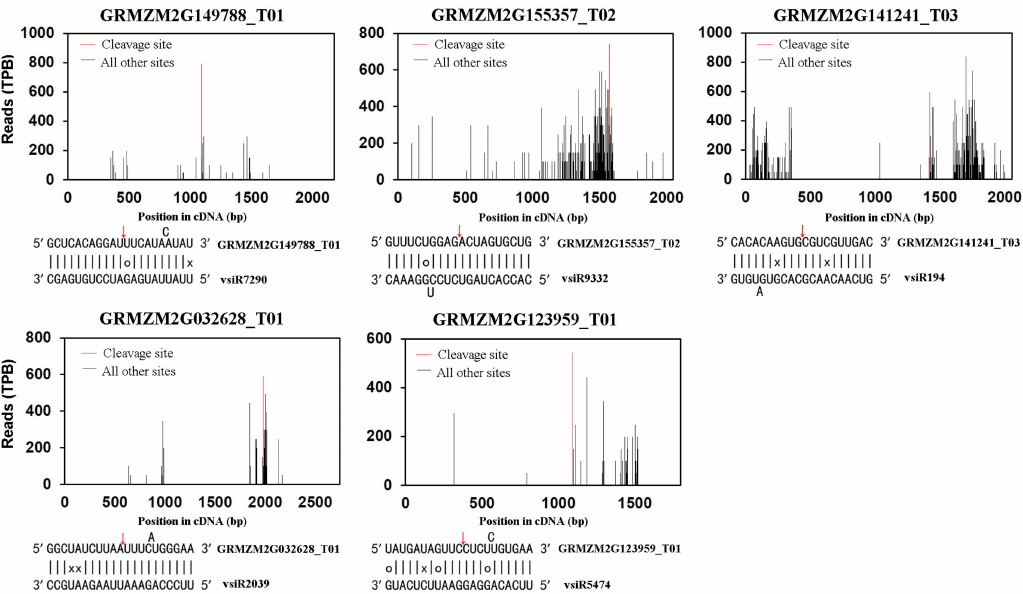
Figure 1. Identification of maize transcripts targeted by vsiRNAs through degradome sequencing. Target plots for the indicated genes showed sequencing signature abundance at the position of target transcripts identified through degradome sequencing. The red lines indicate the predicted vsiRNA cleavage sites. Signature abundance along the mRNA was normalized to the transcripts per billion (TPB) reads. The red arrows in the mRNAs represent the cleavage sites identified through degradome sequencing. Wobble G-U pairs are indicated with circles and no base pairing is indicated with a ‘ ×